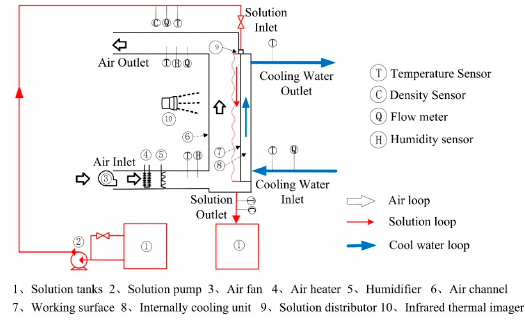
Figure 3. Schematic diagram of the experimental system.